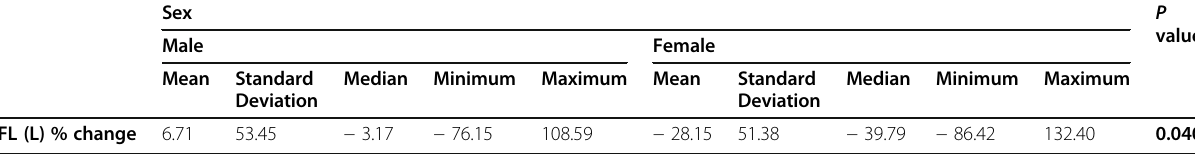
Table 3 The correlation between percentage change of the left frontal lobe with the sex of the patients